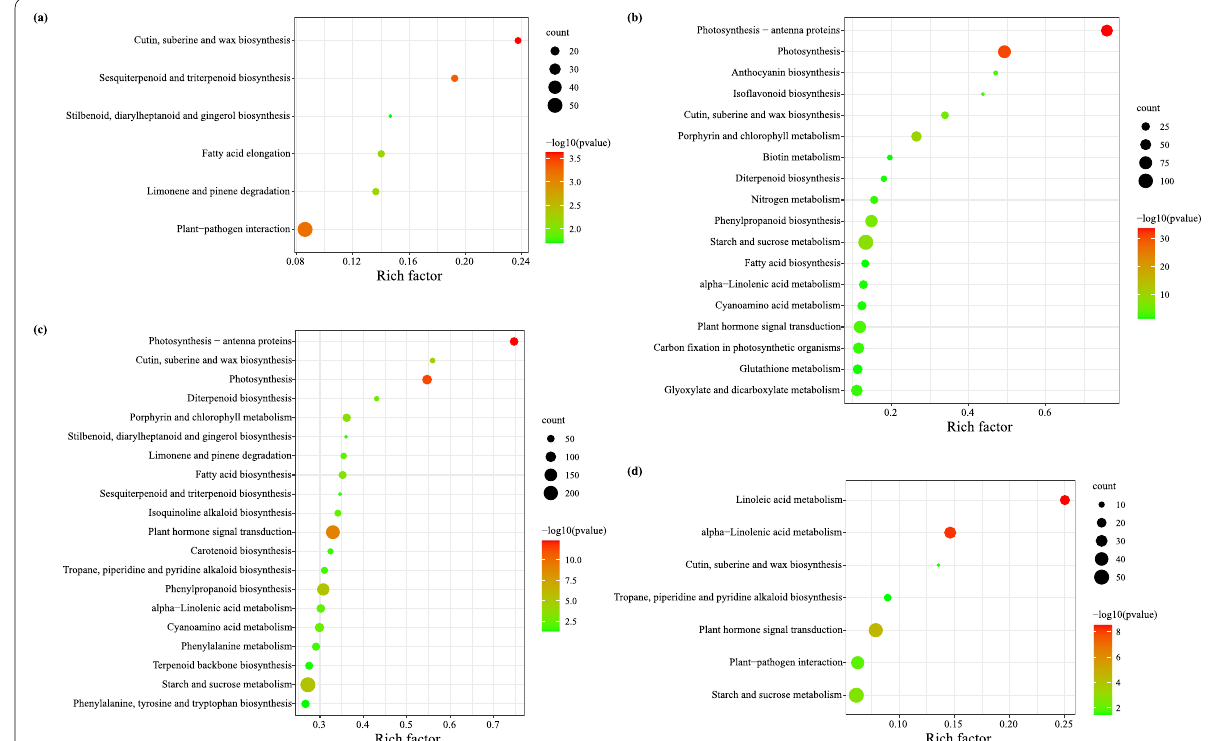
Fig. 4 KEGG Pathway enrichment diagram of differentially gene expression between female and male of E.agallocha in different comparison groups. a Ea_ff vs Ea_mf group. b Ea_ff vs Ea_fL group. c Ea_mf vs Ea_mL group. d Ea_fL vs Ea_mL